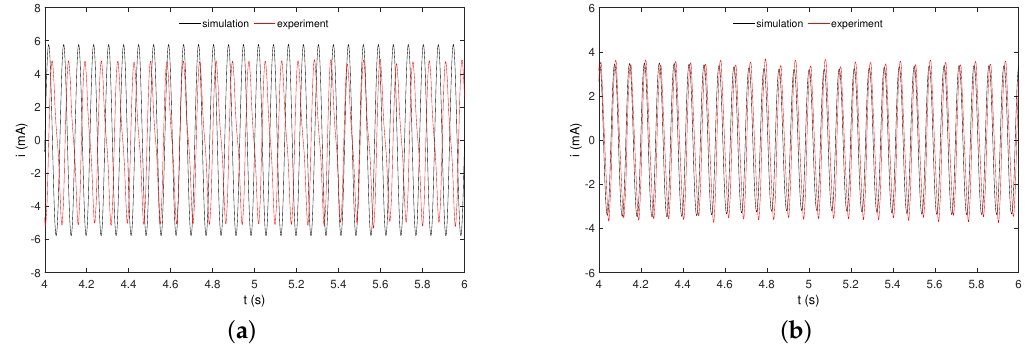
Figure 14. Experimental and numerical recovered currents obtained for parameters: α = 70 V/A, R = 2 k Ω ( a ) and α = 25 V/A, R = 10 k Ω ( b ). The frequency and amplitude of excitation were ω = 88 rad/s and Q = 0.6